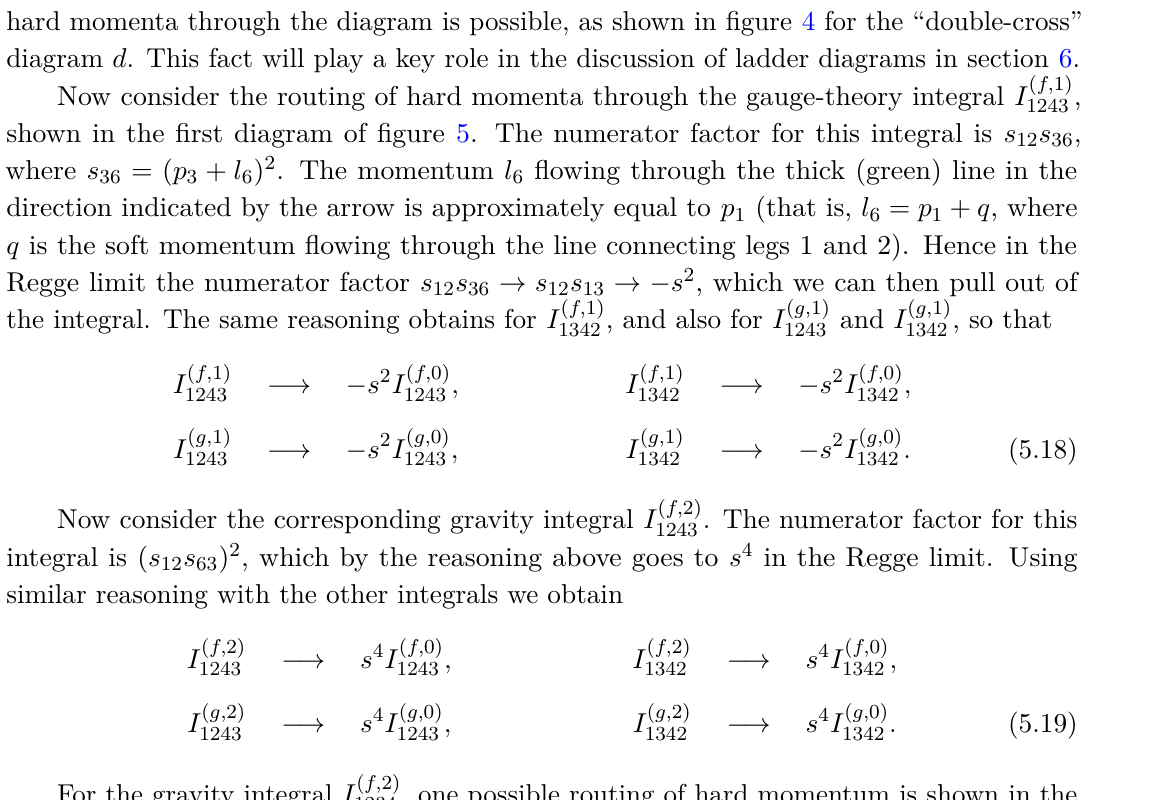
, I ( f ) , and I ( f ) 1243 1234 1423